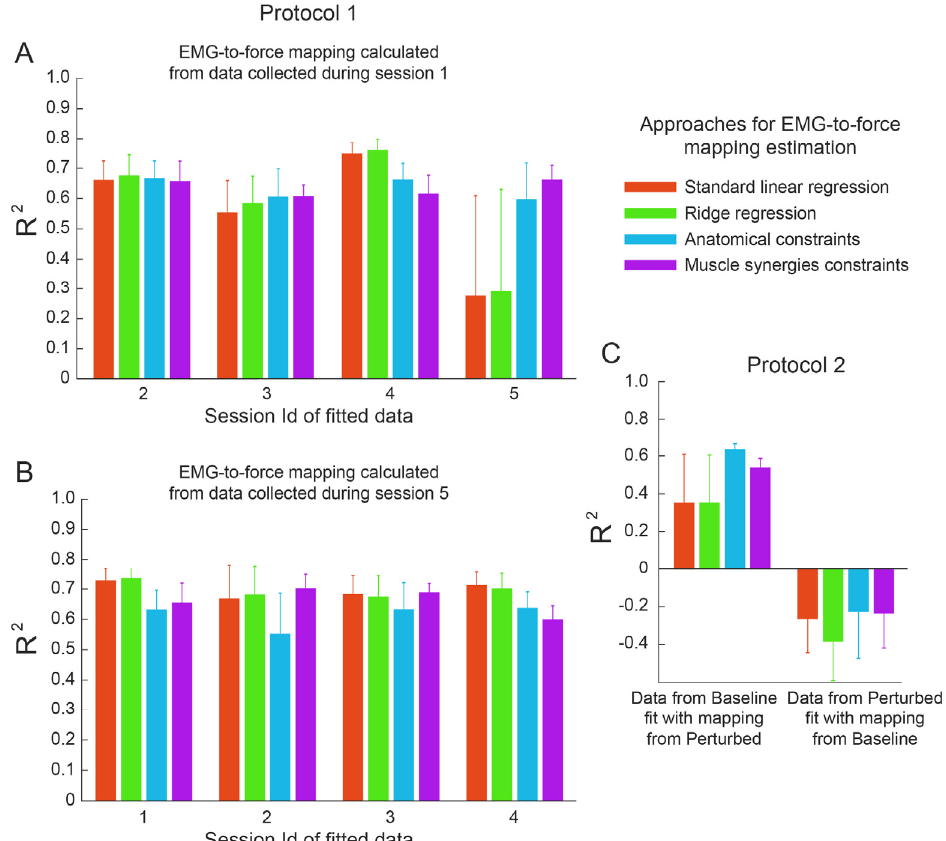
Figure 6. Results of the cross-dataset fitting. R 2 values calculated by fitting a dataset collected during a session/condition with an EMG-to-force mapping extracted from data collected during another session/condition. Different colors are related to different estimation approaches. ( A ). R 2 values (mean ± SE across participants) obtained by fitting data collected during sessions 2 to 5 of protocol 1 with the EMG-to-force mapping estimated using data collected during session 1. ( B ). R 2 values obtained by fitting data collected during sessions 1 to 4 of protocol 1 with the EMG-to-force mapping estimated using data collected during session 5. ( C ). R 2 values obtained by fitting data collected during the baseline block with the EMG-to-force mapping estimated using data collected during the perturbed blocks ( left ), and by fitting data collected during the perturbed blocks with the EMG-to-force mapping estimated using data collected during the baseline block ( right